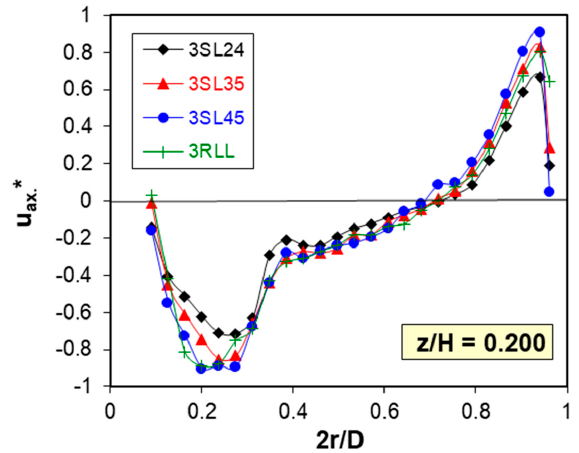
Figure 3. Dimensionless axial velocity profiles in an agitated batch for a measuring level passing the discharge stream of the impeller [5].